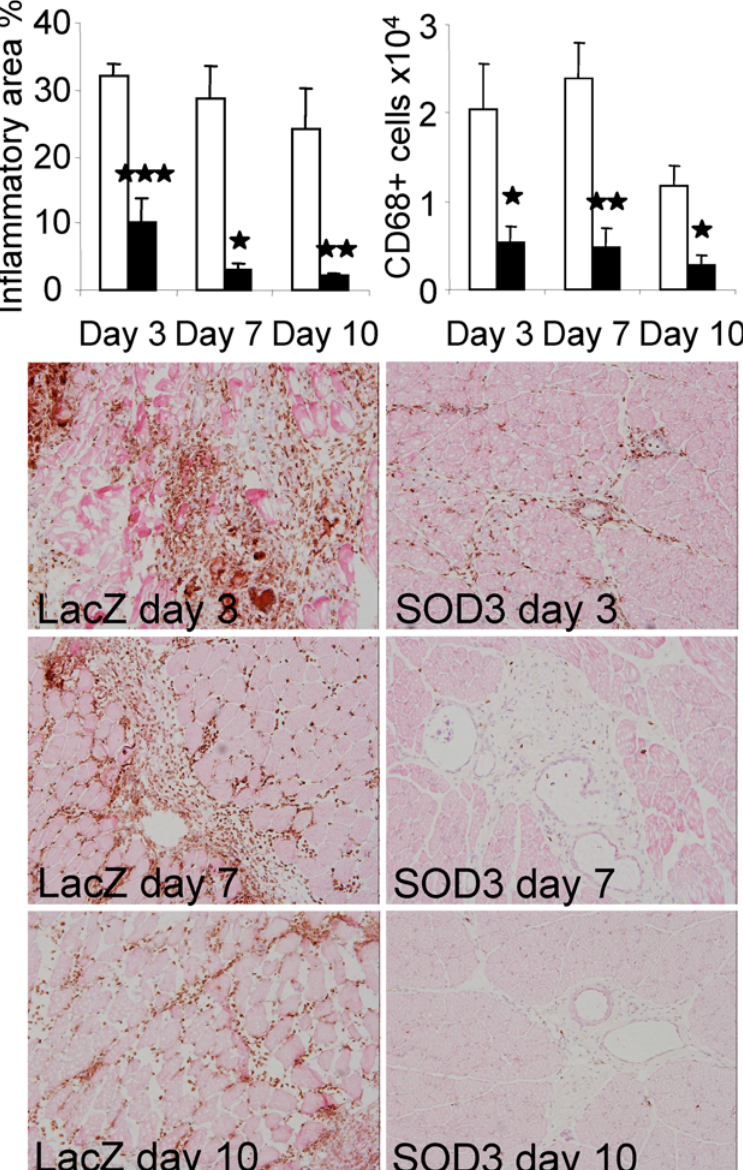
Figure 1. Reduced macrophage infiltration in to ischemic muscle. Open bars represent LacZ animals and black bars represent SOD3 animals. CD68 staining showed significantly reduced inflammatory area and macrophage infiltration in SOD3 animals at all time points studied. Histological stainings show CD68 + macrophages around the femoral artery in ischemic muscles (20 6 magnification).